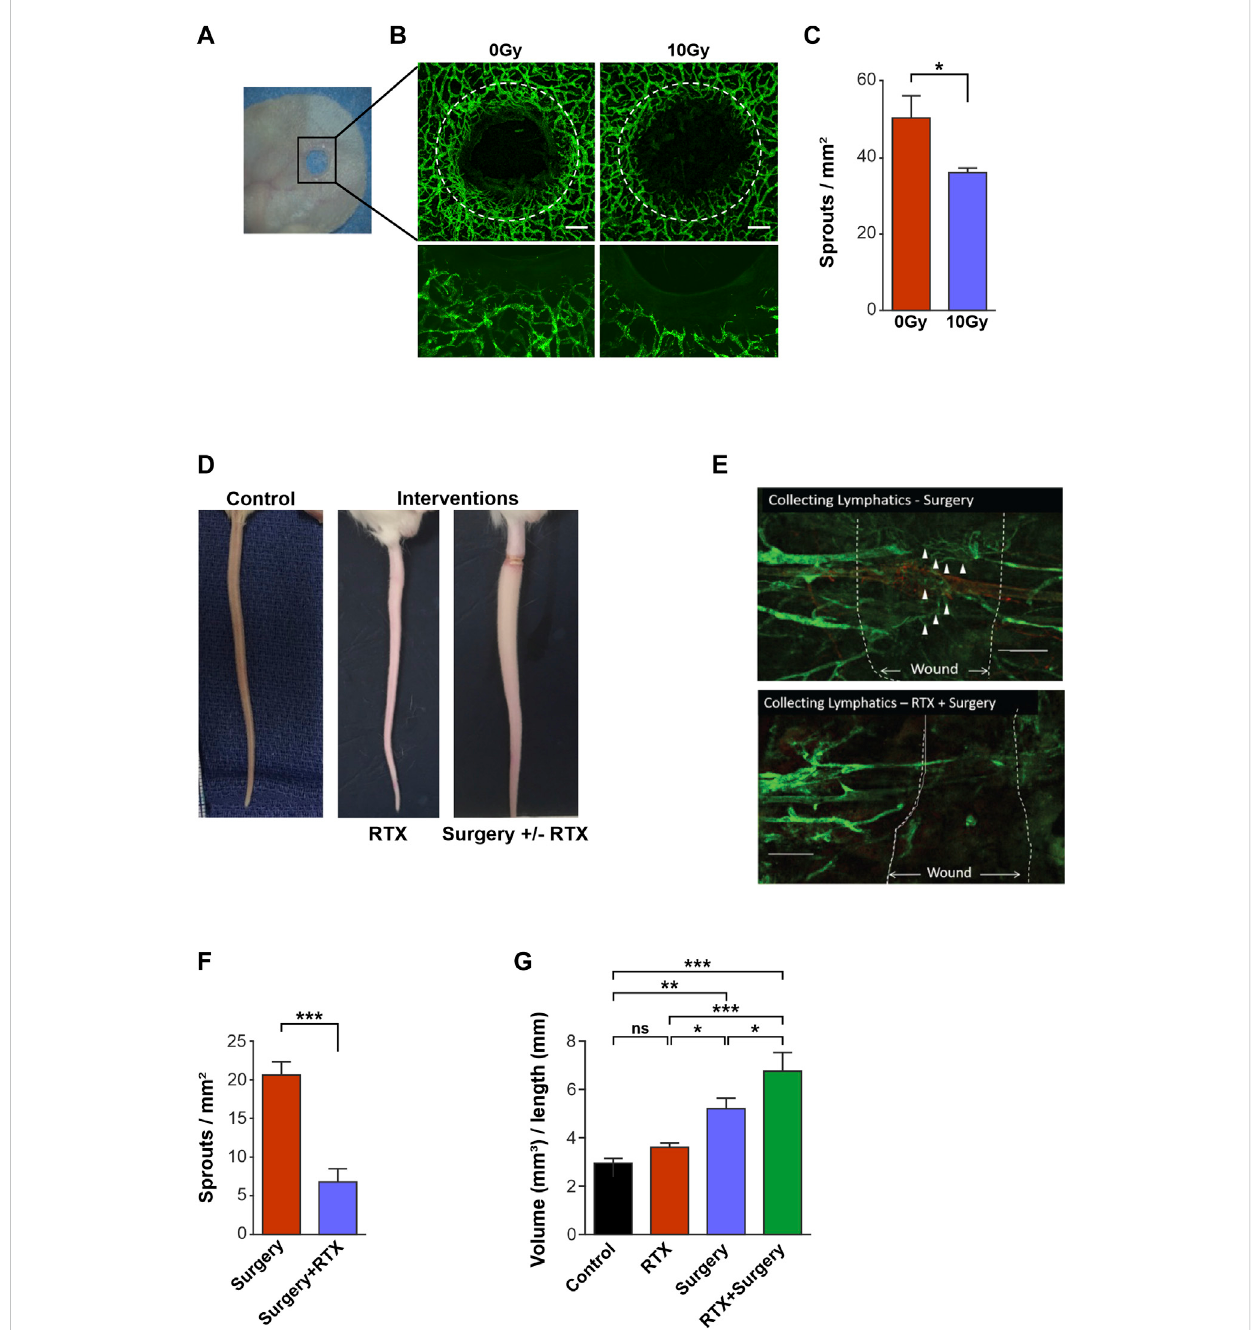
FIGURE 1 Radiotherapyreduceslymphangiogenesisandimpairslymphaticfunction invivo. (A) PhotographshowingtheearwoundmodelinthePROX1-GFP1 mouse. (B) Confocal images of 0 Gy Control and 10 Gy irradiated ears 3 weeks post-treatment in the PROX1-GFP mouse. Photos with x4 objective (top images) and high objective images with x20 objective (bottom). Lymphatics are green, white dashed lines indicate wound edges and scale bars denote 200 μ m. (C) Quanti fi cation of lymphatic sprouts on the regenerating wound edge in 0 Gy and 10 Gy ears at the 3-week timepoint. (D) Photographs showing a normal (non-operated, non-irradiated) tail (left) and a lymphoedematous tail resulting from interventions of radiotherapy (RTX) and surgery ± RTX. (E) Confocal microscopy, x10 objective, of the surgical tail model demonstrating lymphangiogenesis ( Δ ) across the surgical wound in the surgeryonlysetting(top)andtheradiotherapy(RTX)withsurgerysetting(bottom),withwhite dashedlinesdenotingtheedgesofthesurgicalwounds. (F) Quanti fi cation of lymphatic sprouts across the surgical wound comparing surgery alone vs. RTX with surgery. (G) Tail volume quanti fi cation to demonstrate differing degrees of lymphoedema after interventions of control, RTX alone, surgery alone and RTX with surgery. All assays performed a minimum of3times(withatleast3technicalreplicatesperassay). Dataexpressedas mean,errorbarsrepresentSEM. p -valuescalculated usingStudent ’ s t -test (panels C and F) or one way ANOVA (panel G) (* < 0.05; ** p < 0.01; *** p < 0.0001, ns = not signi fi